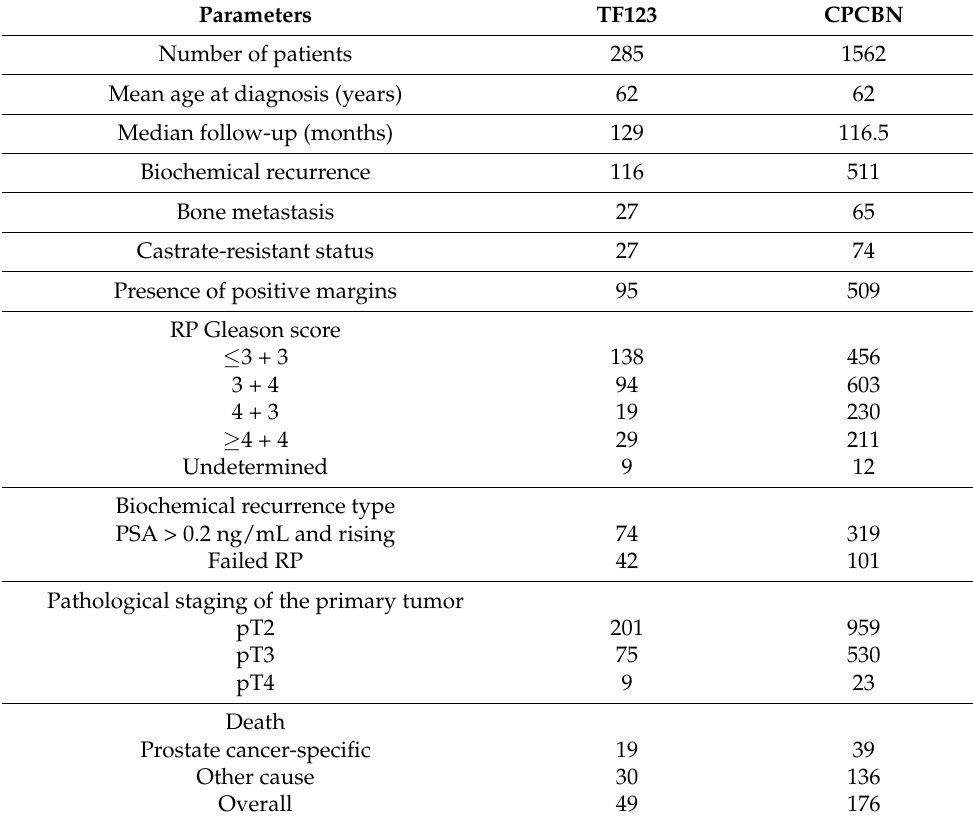
Table 1. Description of the TF123 and Canadian Prostate Cancer Biomarker Network (CPCBN) cohorts. Parameters TF123 Number of